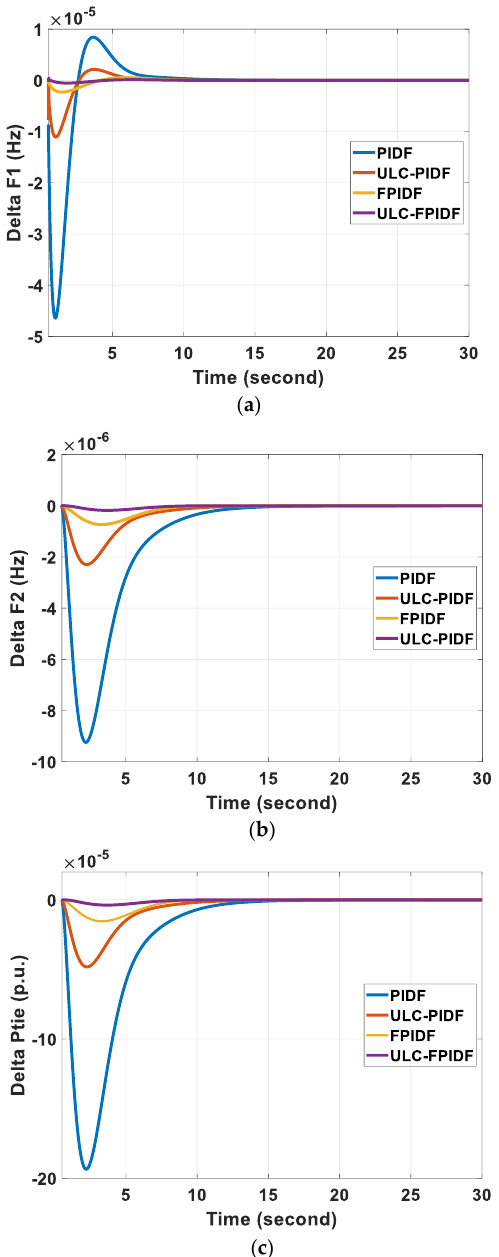
Figure 10. Dynamic response for 5% SLP using different controllers: ( a ) ΔF 1 , ( b ) ΔF 2 , and ( c ) ΔP tie . Figure 10. Transient response for 5% SLP using different controllers: ( a ) ∆ F 1 , ( b ) ∆ F 2 , and ( c ) ∆ P tie The maximum overshoot (MO), maximum undershoot (MU), and settling time (Ts) for F 1 , F 2 , and P tie , respectively, are shown in Table 4 as the system dynamic results for 5% SLP. The lowest values of maximum overshoot, maximum undershoot, and settling time are given by the proposed MPA-based ULC-fuzzy PIDF controller, followed by the con- ventional MPA-based fuzzy controller and the ULC-PIDF. However, the MPA-based clas- sical PIDF controller obtains the maximum value of maximum overshoot, maximum un- dershoot, and settling time. The suggested ULC-fuzzy PIDF controller generally enhanced the maximum undershoot, maximum overshoot, and settling time values of the system responses by around 98.8%, 98.45%, and 61.1%, respectively, as compared to the standard PIDF controller. Table 4. Transient expectations for 5% SLP utilizing various controllers. ΔF 1 (Hz)